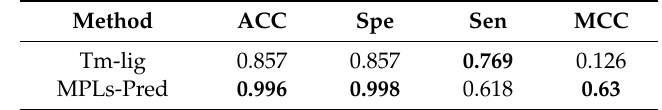
Table 5. Comparison of MPLs-Pred with the previous study on the independent dataset. Method